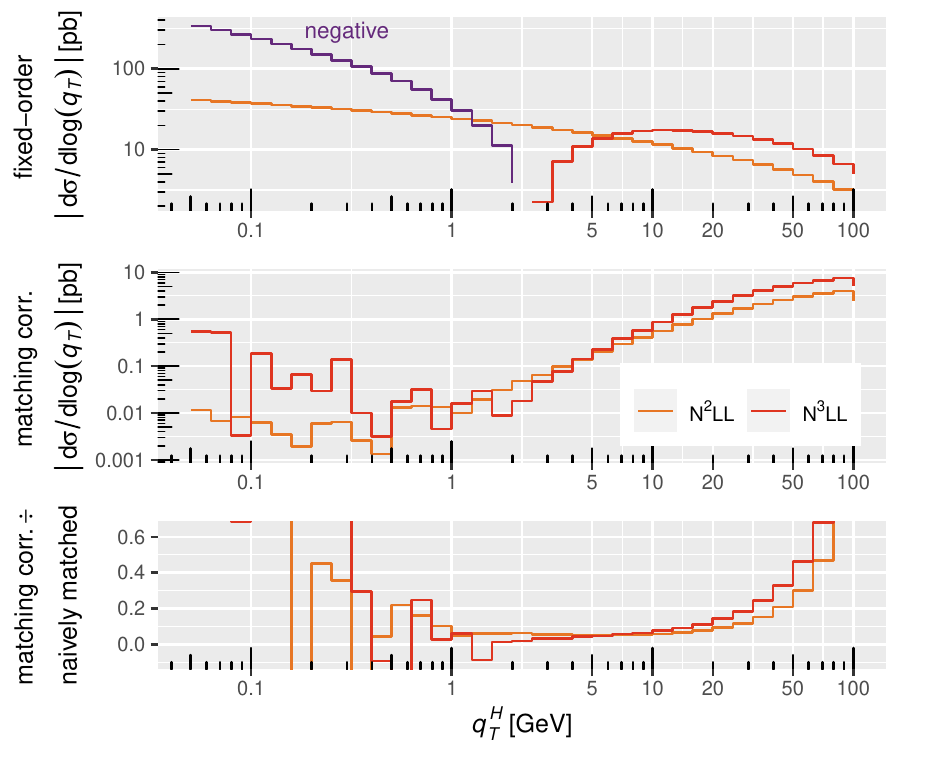
Figure 4. Top panel: fixed-order prediction at LO and NLO for inclusive Higgs production. Middle panel: absolute value of the matching corrections to show the cancellation towards q T → 0 and the resulting loss of numerical accuracy at very small q T . 1 GeV . Bottom panel: matching corrections relative to the naively matched